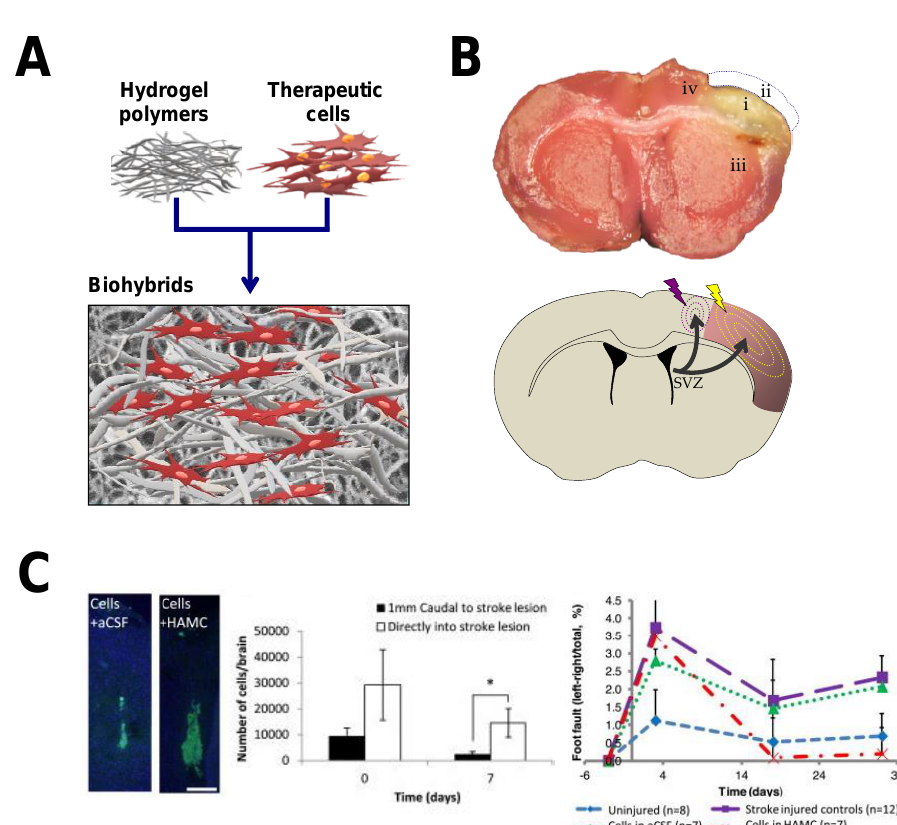
Figure 3. Neurorestorative potential of hydrogel-based biomaterials in ischemic stroke. ( A ) For encapsulation of cells and factors, different natural and synthetic polymers alone or in a mix have been manufactured and injected into different anatomic brain regions. ( B ) On the top, representative image of a coronal brain section stained with triphenyltetrazolium chloride (TTC) 24 h after distal middle cerebral artery occlusion, one of the stroke rodent models more regularly used [8]. In this model, the infarct area is mainly restricted to the brain cortex (“white” area in the right hemisphere) and the implantation of cells and hydrogels has been generally performed at different regions including: the stroke cavity (i); epicortically (ii); striatum (iii); or in the cortical area bordering the lesion cavity (iv). On the bottom, SCs might neuroprotect the brain by diminishing apoptosis and the post-ischemic inflammatory response. Furthermore, functional recovery induced by hydrogels and cells might be ascribed to regenerative processes in the damaged tissue (illustrated in the scheme by yellow dashed lines) or structural changes (tissue remodeling) in perilesional regions (violet dashed lines). Most of these changes are produced by previous stimulation of endogenous neurogenesis in the sub-ventricular zone (SVZ). ( C ) Example of the neuro-therapeutic potential of neural stem cells and progenitors (nSCs) integrated into hyaluronan-methylcellulose (HAMC) hydrogels. The engraftment and survival of nSCs into the mouse brain was favored when injected in HAMC hydrogels (left graph, scale bar 200 µ m), with higher rates of survival when the cells enclosed in the biomaterial were injected into the stroke lesion (endothelin-1 model) than when they were implanted in healthy areas surrounding the damaged tissue (middle graph). The mice transplanted with nSCs delivered in HAMC hydrogels showed significant post-stroke functional recovery (right graph). Results in ( C ) reproduced with permission from [155], published by Cell Press, Elsevier Inc., 2015.